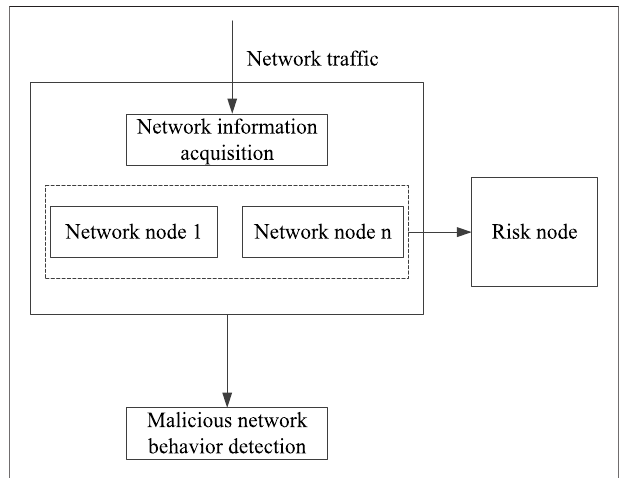
FIGURE 2 | Work fl ow of the malicious network behaviour detection module.